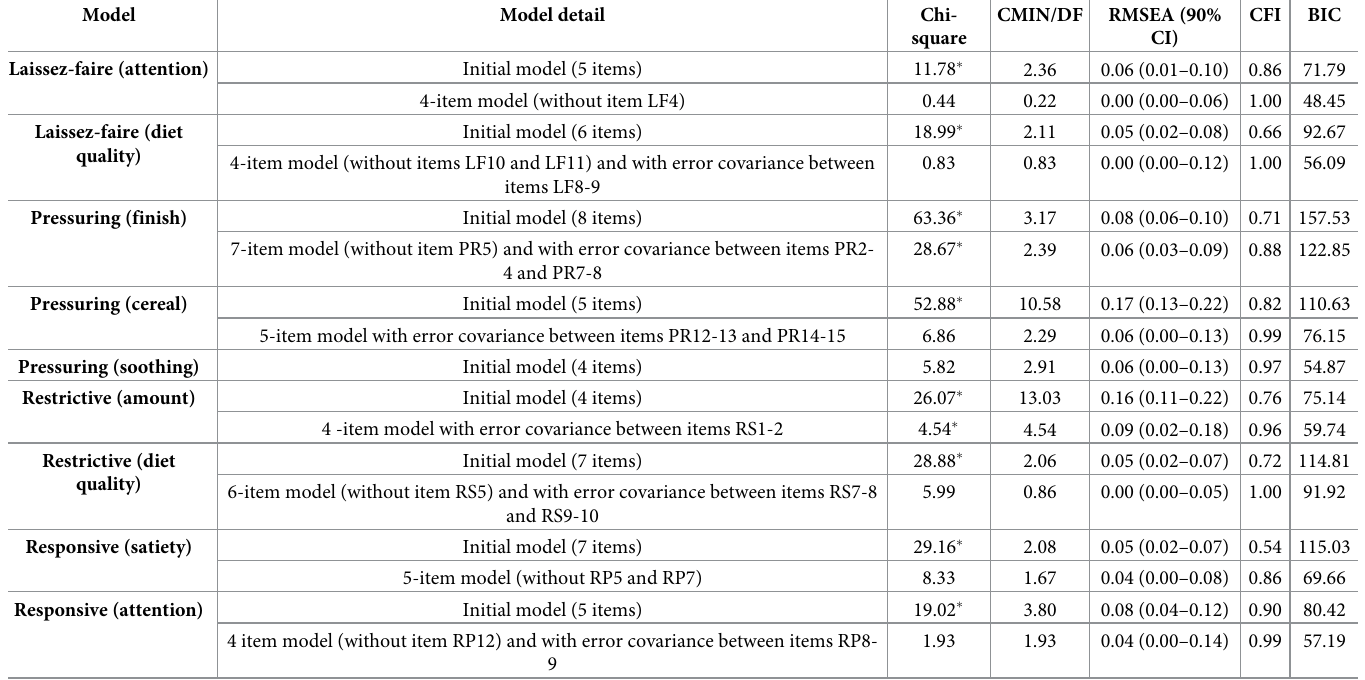
Table 3. Model fit indices from the Confirmatory Factor Analysis for each sub-construct of the Brazilian Portuguese version of the Infant Feeding Style Question- naire (IFSQ-Br). Federal District, Brazil. 2018.